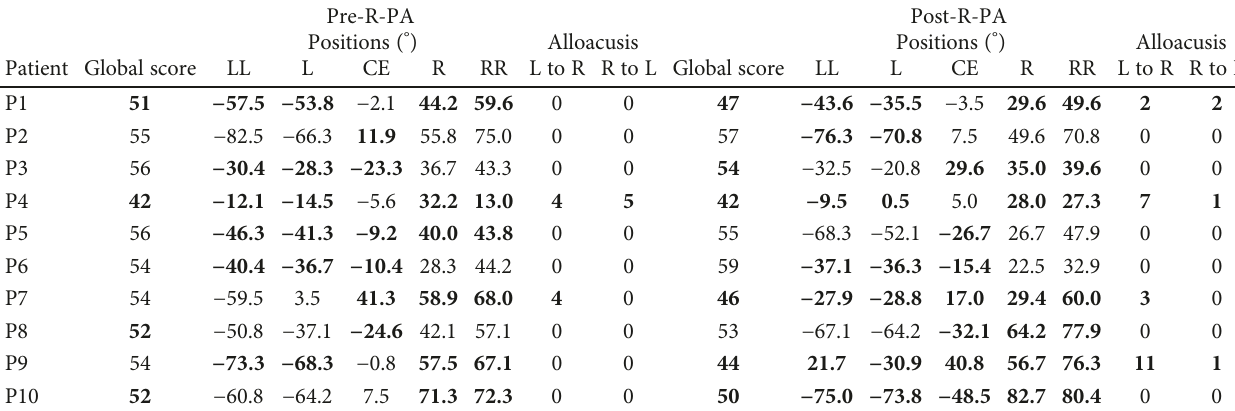
Table 3: Performance in auditory localization before (pre-R-PA) and after (post-R-PA) exposure to R-PA. Scores outside the normal range are in bold. The global score corresponds to the number of stimuli correctly placed to the left or the right of the previous stimulus. The perceived positions of each of the fi ve stimulus locations are indicated in degrees (positive in the right, negative in the left space). The ability to discriminate between the two positions within either hemispace (LL versus L; R versus RR) was assessed by t -tests; positions which failed to be discriminated are highlighted in bold. In the control population, 10% of subjects failed to discriminate the two positions within one hemispace, never within both hemispaces. The number of alloacusis is indicated separately for those where stimuli presented on the left were indicated on the right (L to R) and those where stimuli presented on the right were indicated on the left (R to L). Control subjects never presented alloacusis.